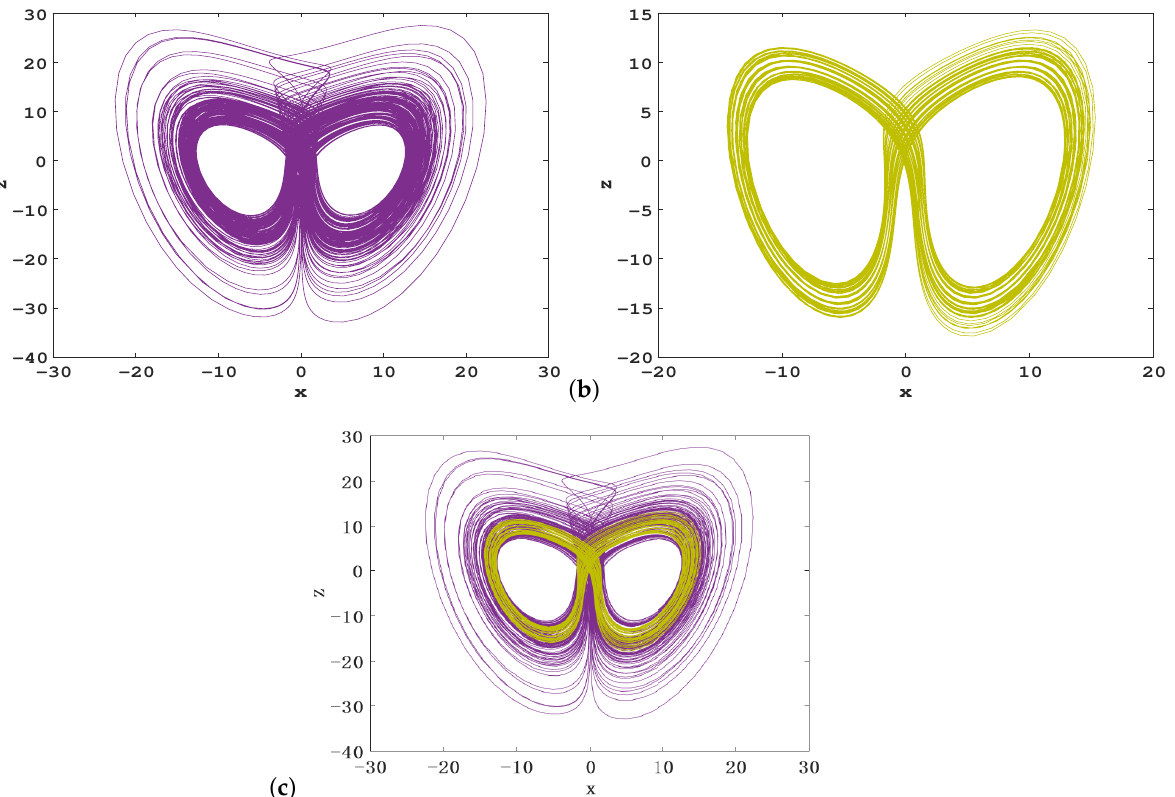
Figure 10. Two coexisting hidden attractors of system (2); ( a , b , c , k , m ) = ( 10,40,2.7, − 0.2,2 ) ; ( a ) chaotic attractor; ( b ) quasi-periodic attractor; ( c ) coexisting attractors. The purple line repre- sents chaotic attractor and the yellow line represents quasi-periodic